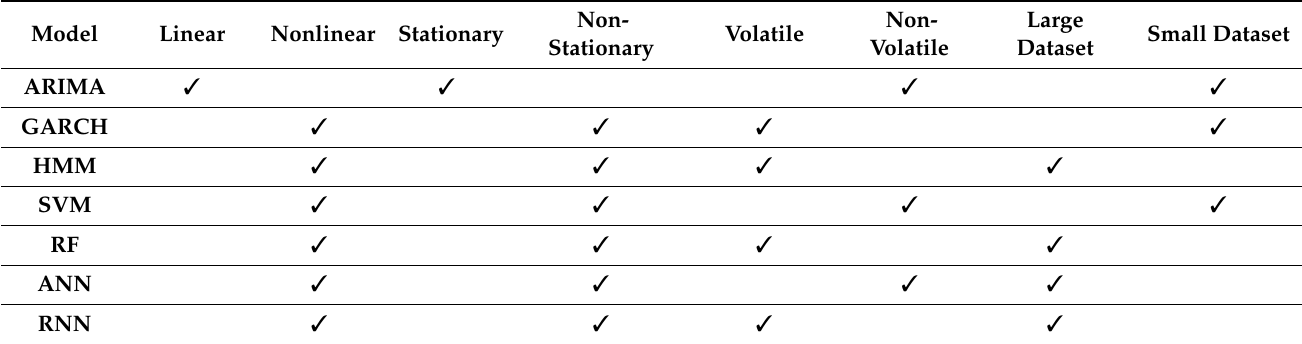
Table 10. Optimal model selection with its suitable data